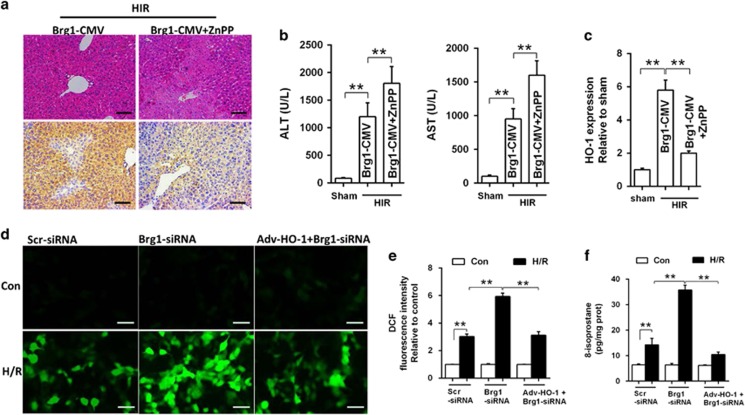
Inhibition of HO-1 reversed the protective effects of Brg1 overexpression. CMV-Brg1 transgenic mice subjected to HIR with or without HO-1 inhibitor ZnPP. Animals were killed at 6 h after reperfusion onset. (a) Liver pathology was detected by H&E staining and HO-1 expression was measured by immunohistochemical staining. Representative images from one of three independent experiments were shown. (b) The effects of HO-1 inhibition on Brg1-CMV mice post-HIR liver function were examined by AST and ALT. (c) Quantitative measurement of HO-1 immunohistochemical staining density in a by densitometry analysis. (d and e) Furthermore, AML12 cells injury was attenuated by overexpression of HO-1 in hepatocytes subjected to H/R (H12R4). Cell DCF fluorescence was detected and relative DCF fluorescence intensity was assayed. Representative images from one of three independent experiments were shown. (f) Cell 8-isoprostane was detected by ELISA assay to show the cellular oxidative stress level. Data are mean±S.E.M. of three independent experiments each performed in triplicate. *P<0.05, **P<0.01, one-way ANOVA with Tukey test. Silencer negative control scrambled (Scr) siRNA was used as a control